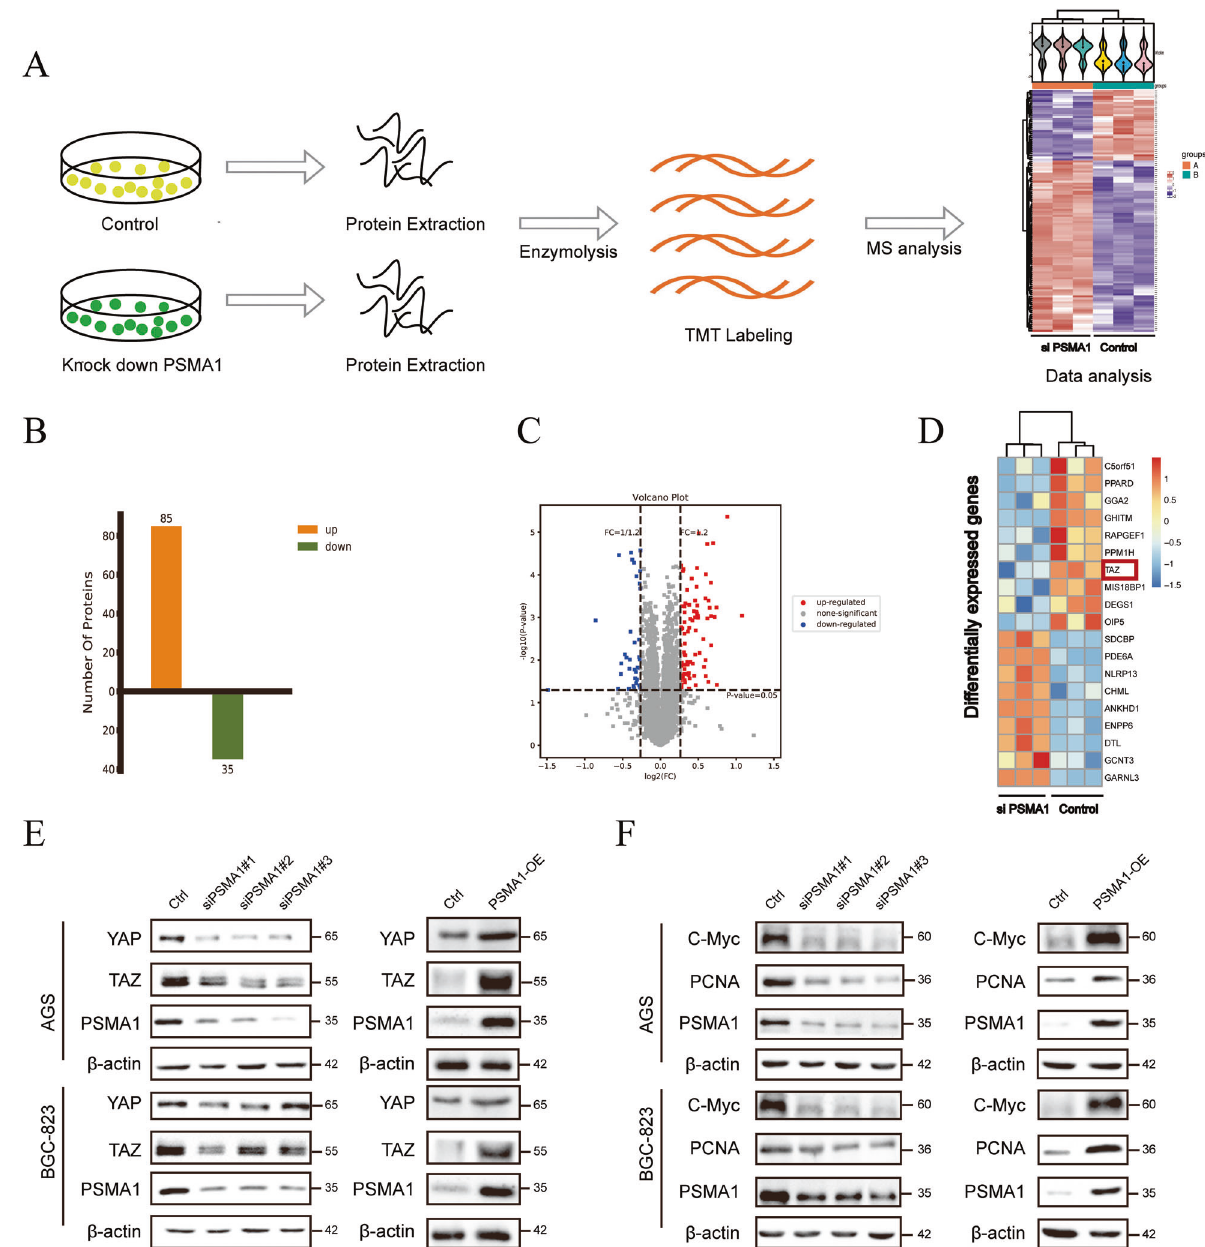
Fig. 2 PSMA1 maintains TAZ stability. A Framework of the TMT labeling quantitative proteomic study . B Upregulated and down-regulated protein by mass spectroscopic analysis. C Volcano plot showing differentially expressed proteins. D Heatmap shows a differentially expressed gene. E Western blot detected YAP and TAZ protein in AGS and BGC-823 cells after transfecting cells with three independent siRNA. Western blot detected YAP and TAZ protein in AGS and BGC-823 cells after transfecting PSMA1-overexpression plasmid. F Western blot detected C-Myc and PCNA protein in AGS and BGC-823 cells after transfecting cells with three independent siRNA or PSMA1-overexpression